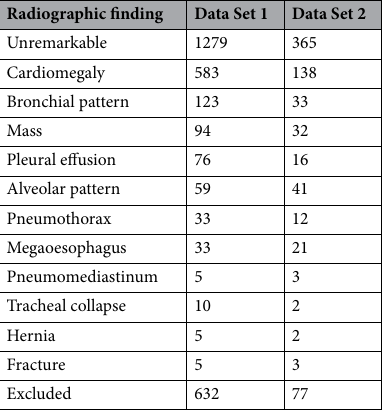
Table 1. Number of LL radiographs showing the following included radiographic